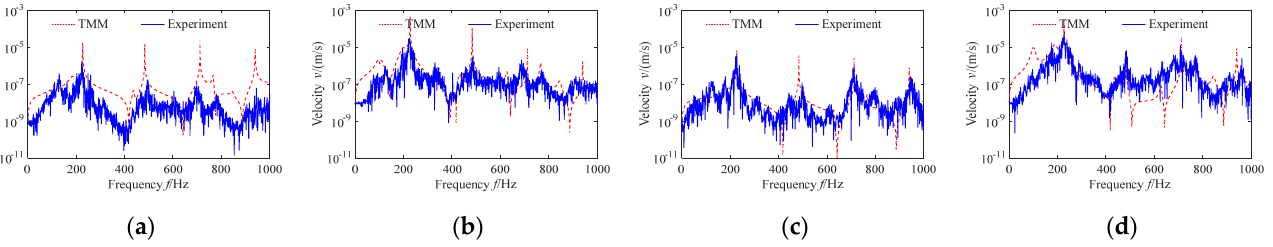
Figure 13. Velocity responses of pipe (case 1). ( a ) Axial velocity of point A. ( b ) Radial velocity of point A. ( c ) Axial velocity of point B. ( d ) Radial velocity of point B. Table 9. Resonant frequencies of pipe (case 1).